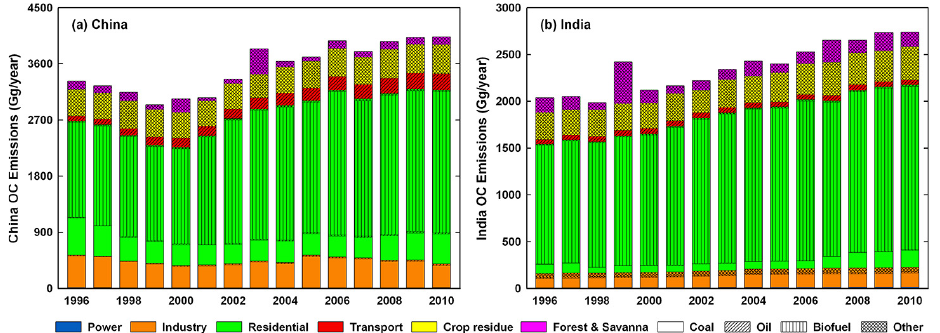
Fig. 4. OC emissions by sector and fuel type in (a) China and (b) India during